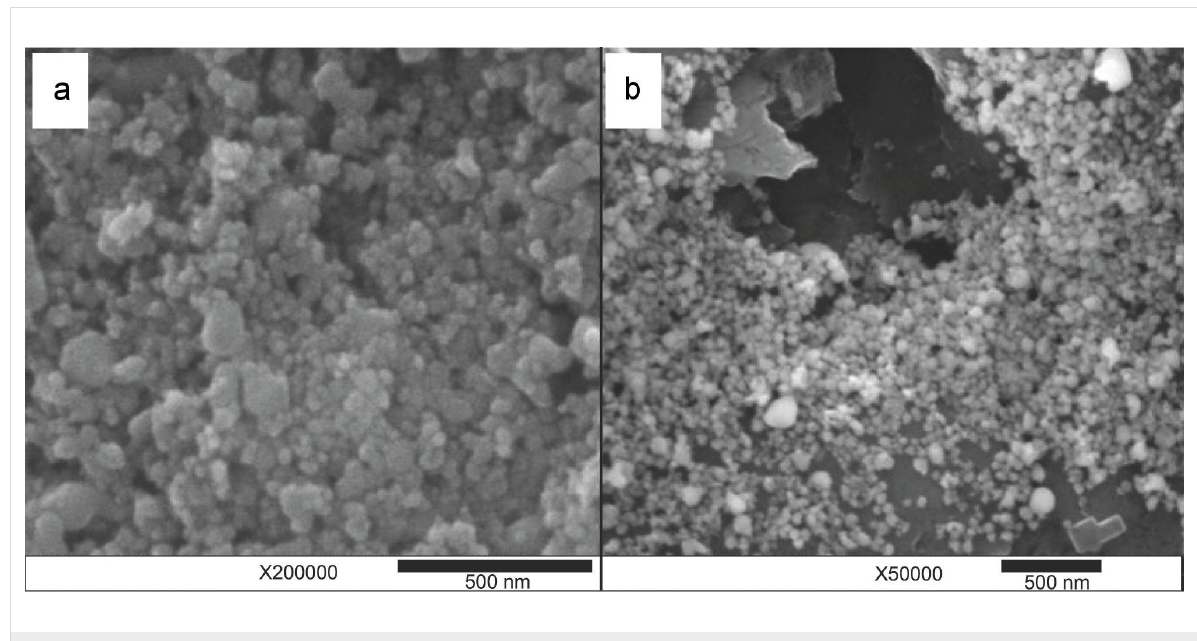
Figure 3: SEM images for (a) ZrO 2 and (b)